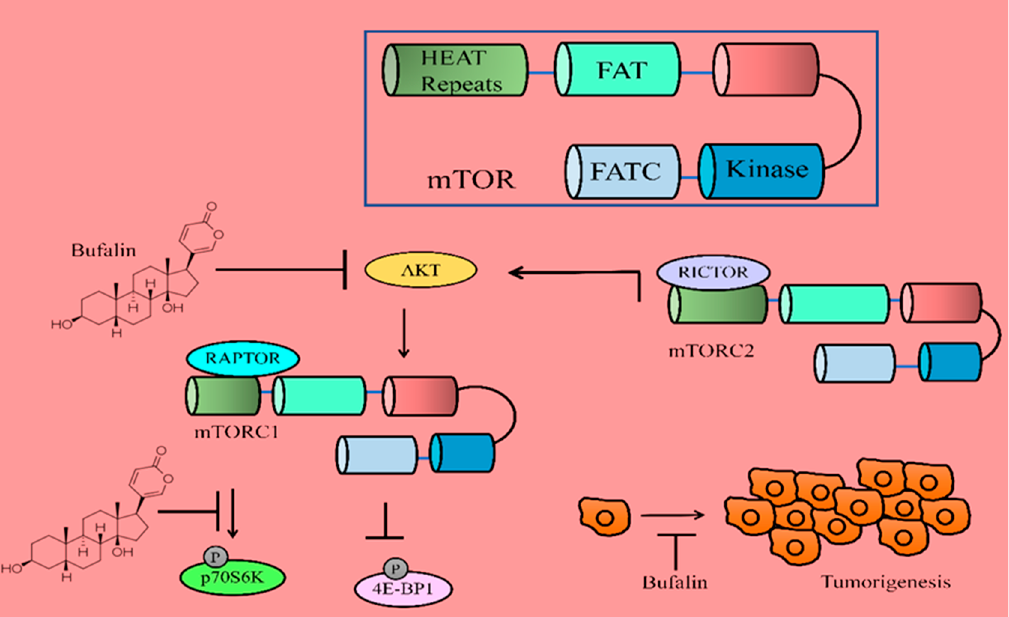
Figure 2. Bufalin mediated inactivation of AKT/mTOR pathway. Bufalin effectively reduced p-AKT, p-mTOR and p-p70S6K. Bufalin inhibited tumor growth by inactivation of AKT/mTOR pathway.